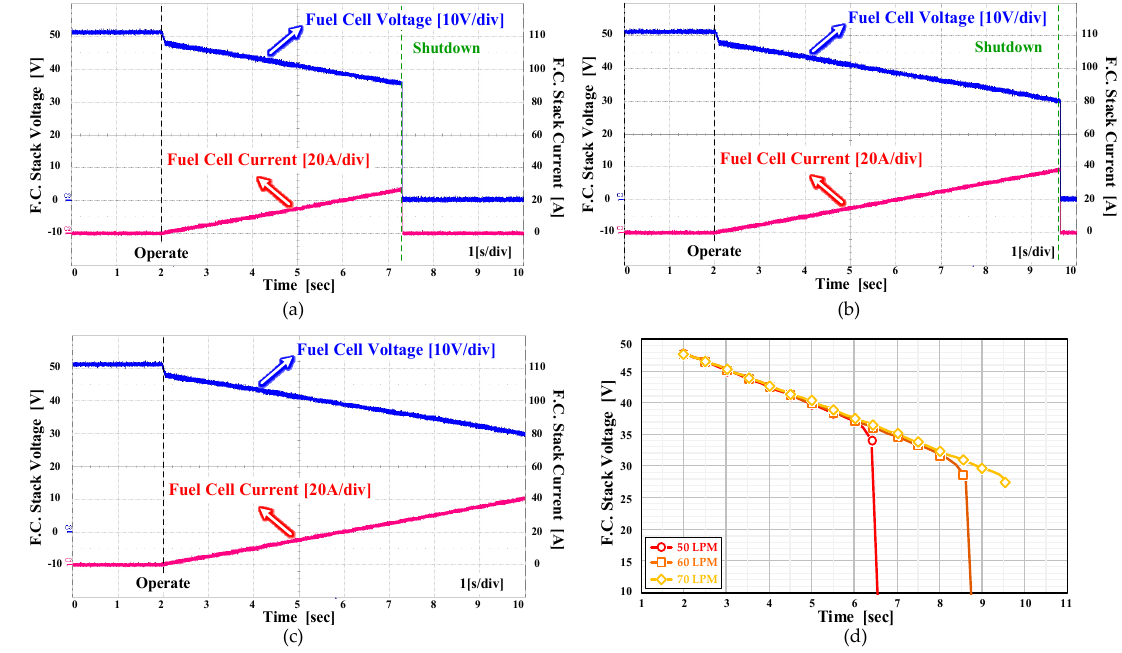
Figure 11. Fuel cell waveforms for supplied hydrogen of ( a ) 50 LPM, ( b ) 60 LPM, ( c ) 70 LPM, and ( d ) voltage drop curve depending on the amount of hydrogen supply.